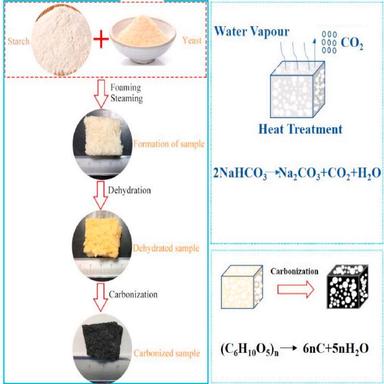
Flowchart for preparing carbon foam.